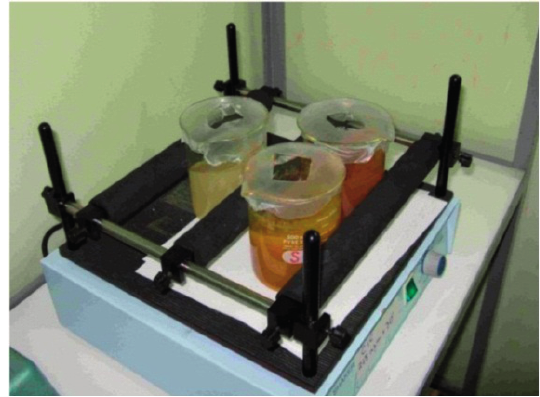
Figure 3. Magnetic stirrer with vessels containing schwertmannite